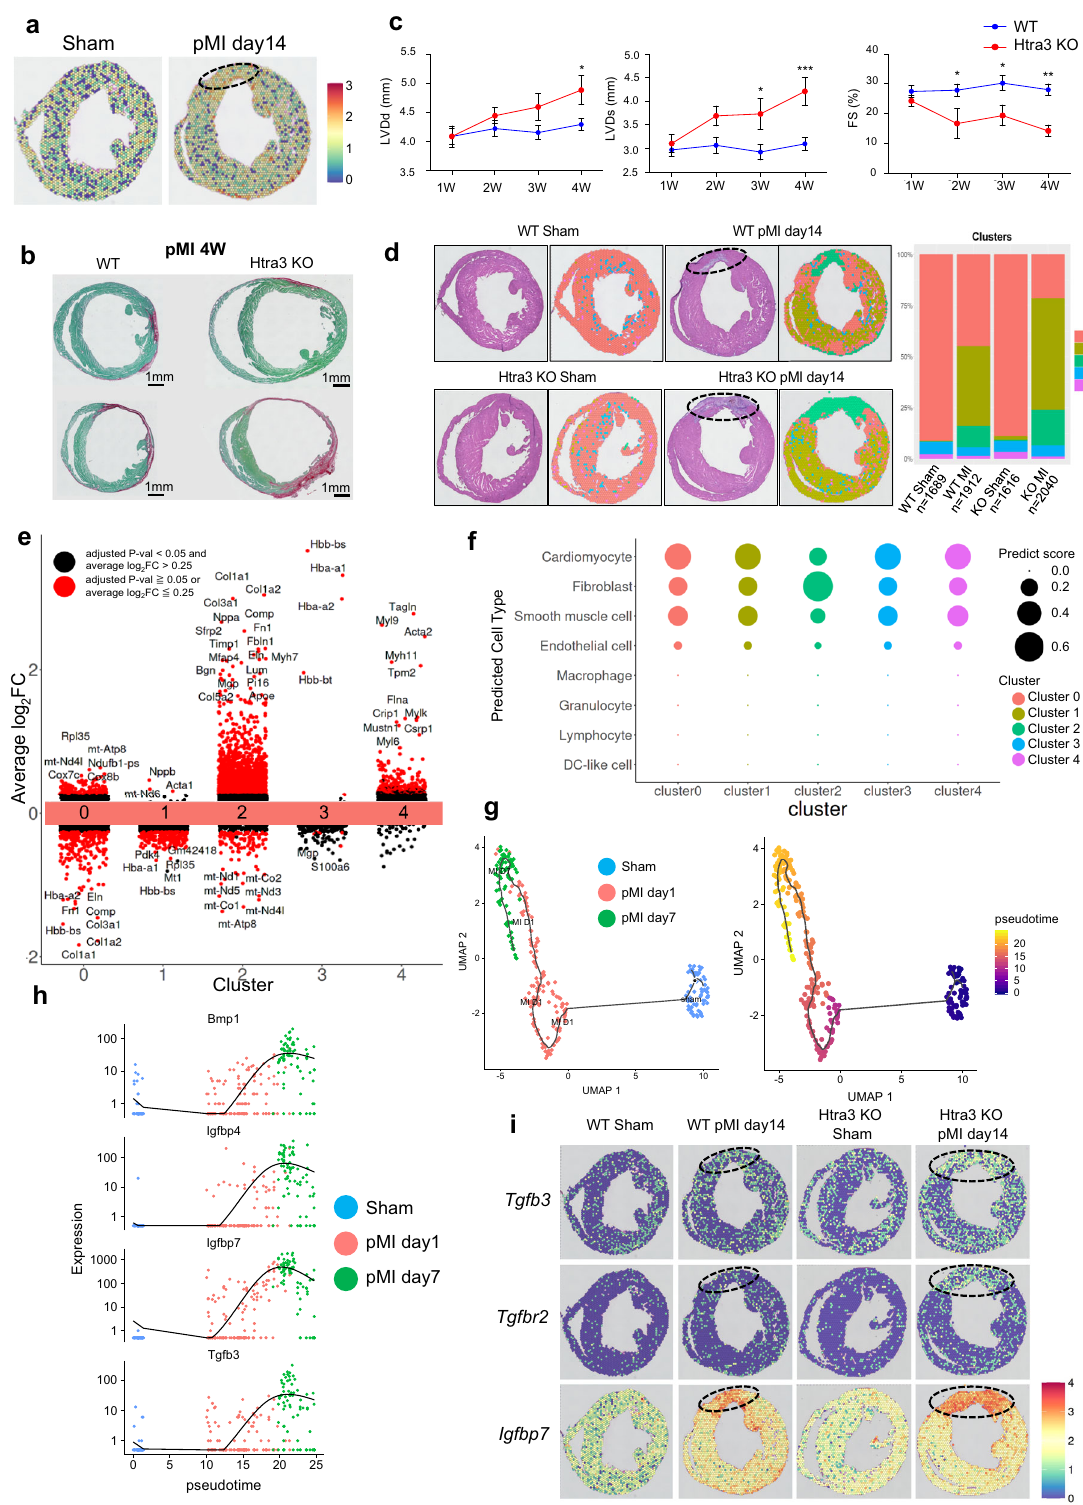
cardiomyocytes were isolated. Single-cell cDNA libraries were generated using the Smart-seq2 protocol 21 . The ef fi ciency of reverse transcription was assessed by examining the Ct values of a control gene ( TNNT2 ) from qRT-PCR using a CFX96 Real-Time PCR Detection System (Bio-Rad). The distribution of the lengths of cDNA fragments was assessed using a LabChip GX (Perkin Elmer) and/or TapeStation 2200 (Agilent Technologies). The following primer set was used